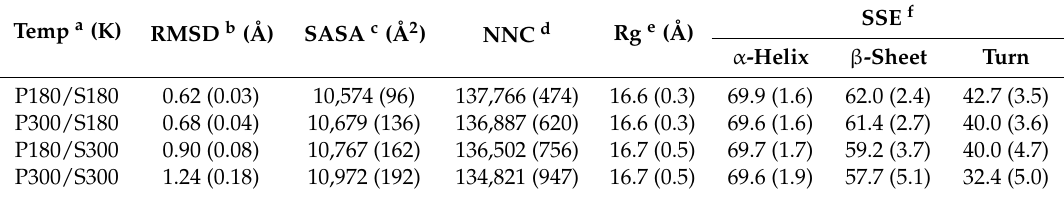
Table 1. Average structural properties (standard deviations are in parentheses) of proteinase K calculated from the joined MD trajectories at the four combined